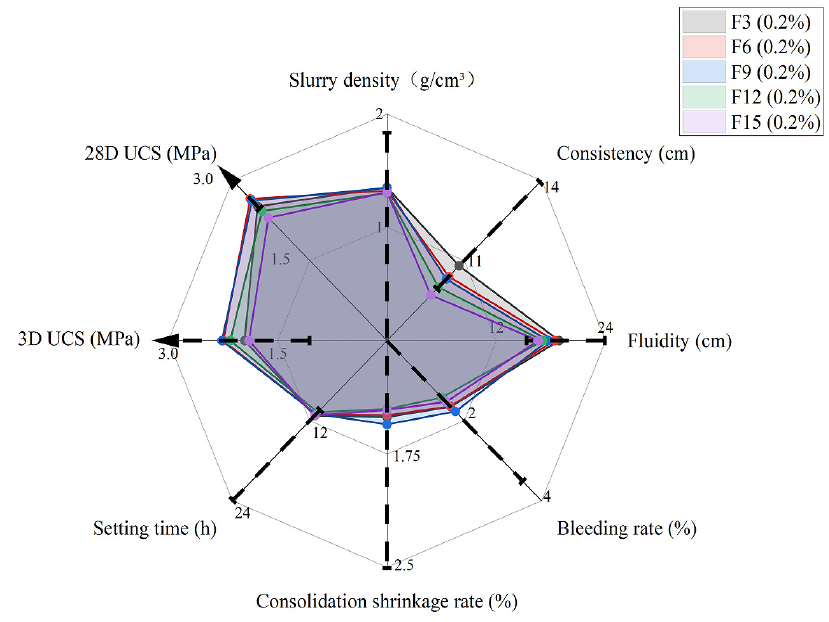
Figure 11. Performance with different fiber lengths at rubber content of 60% and fiber content 0.2%.